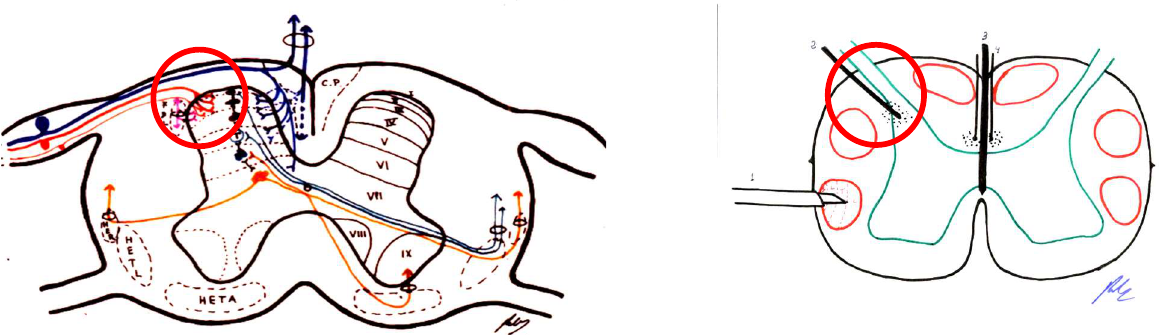
Figure 7. DREZ to be altered (see text). C.P. = P.C. (Posterior cord). HER = SRT (Spinoreticular tract). HETL = LSTT (Lateral spinothalamic tract). HETA = VSTT (Ventral spinothalamic tract). FDL = DLF (Dorsolateral fasciculus, Lissauer’s